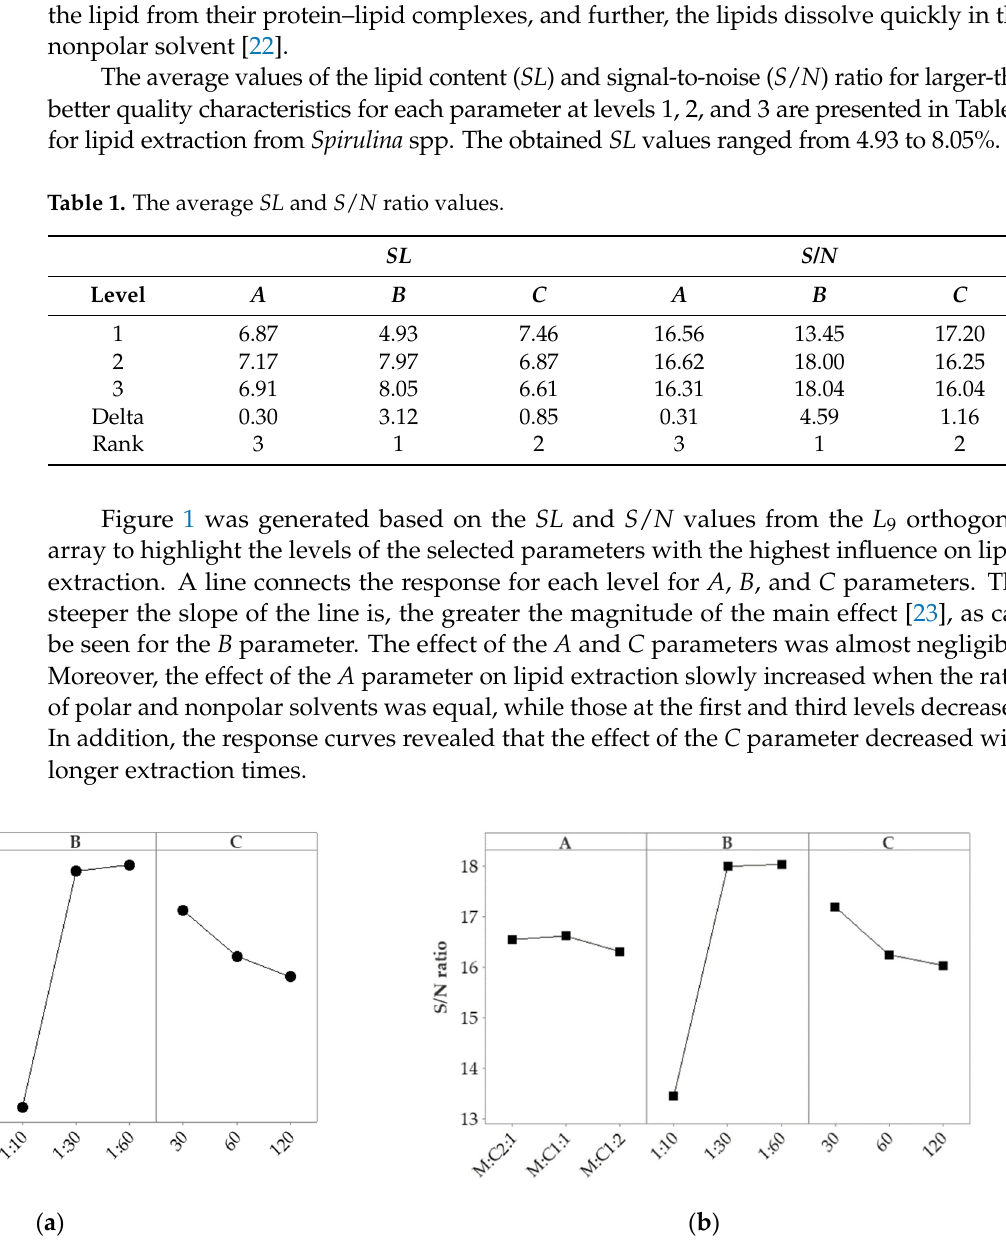
Figure 1. Effect of process parameters on lipid extraction from Spirulina spp.: ( a ) SL ; ( b ) S / N ratio. Table 1 indicates that the second level of parameter A ( A 2 ), the third level of param-